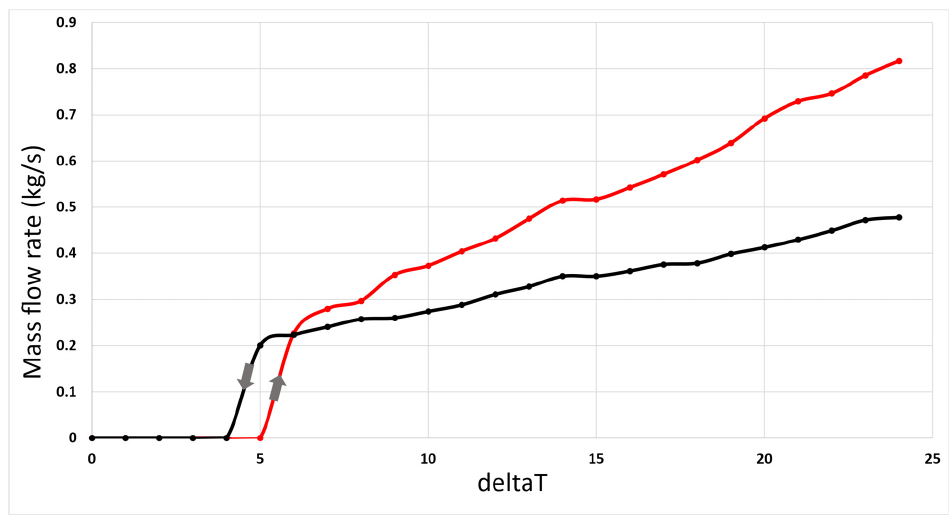
Figure 11. Measured Tech ST-420n characteristic.